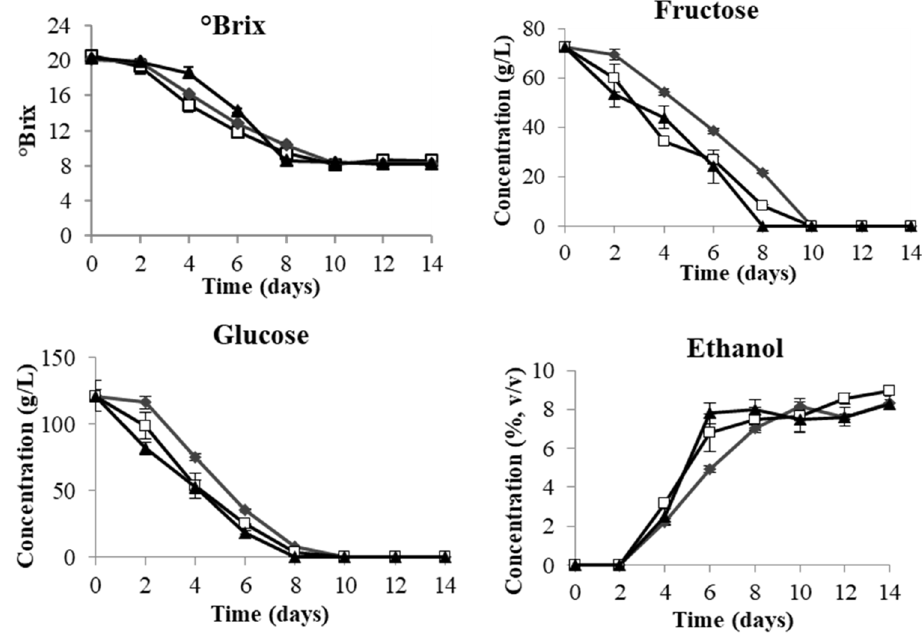
Figure 2. Changes in °Brix, fructose, glucose and ethanol during 14-day fermentation of red dragon fruit juice by T. delbrueckii Biodiva ( ♦ ), L. thermotolerans Concerto ( □ ) and S. cerevisiae EC-1118( ▲ ). Glycerol was detected in significant amounts in all treatments. S. cerevisiae produced the highest amount of glycerol (9.60 g/L), followed by L. thermotolerans (8.03 g/L) and T. delbrueckii (6.07 g/L)